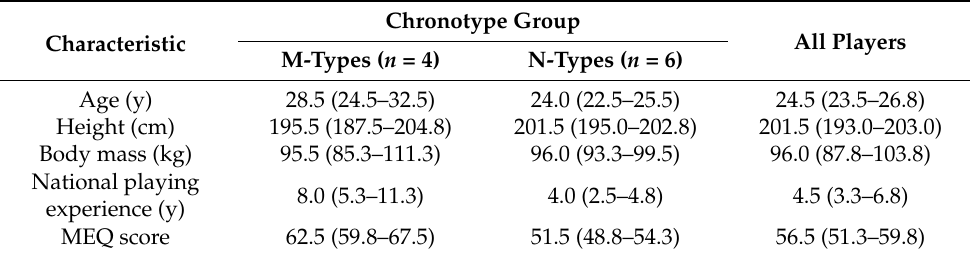
Table 2. Median (inter-quartile range) characteristics of the professional male basketball players recruited in this